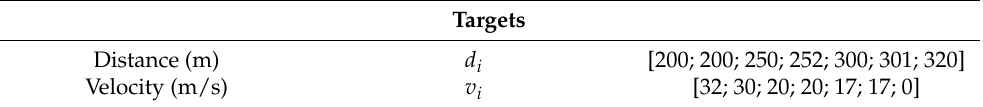
Table 2. Simulated